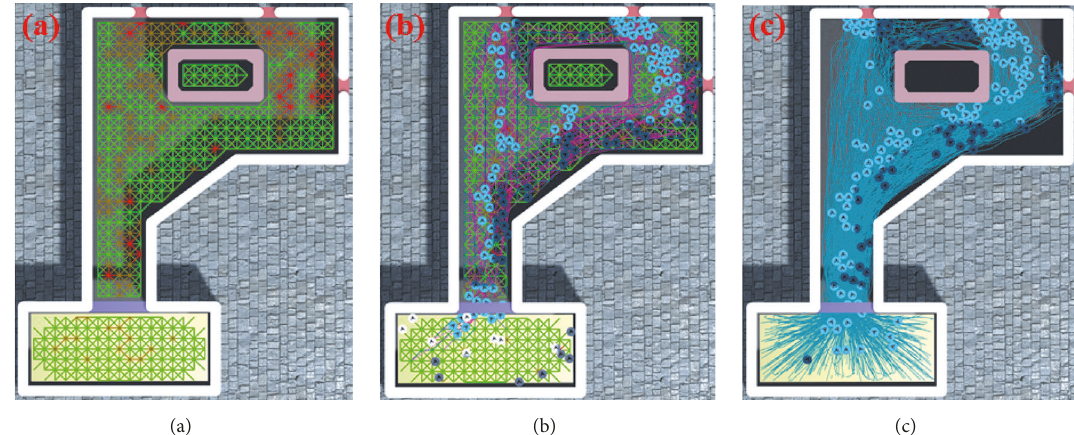
Figure7:Visualillustrationofthespatialgridandpenaltyweights(image(a)),shortestweightedpaths(image(b))andactualmasstrajectories of movements (image (c)). The presence of other pedestrians penalises the nodes and their adjacent links on the spatial mesh (grid) (image (a)). For every simulated pedestrian, once the choice of exit is simulated, the shortest weighted path on the grid is calculated between the location of the pedestrian and the mid-point coordinate of the chosen exit. That shortest path is subsequently truncated to generatea smooth path (image